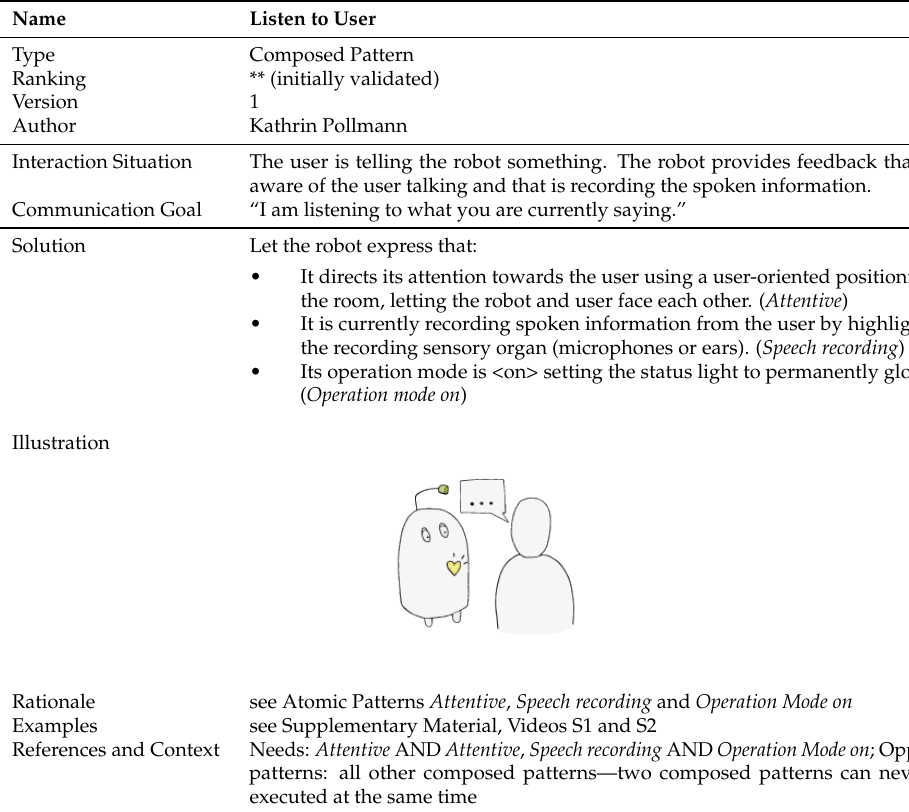
Table A1. Formal documentation of the pattern for the robot action “listen to